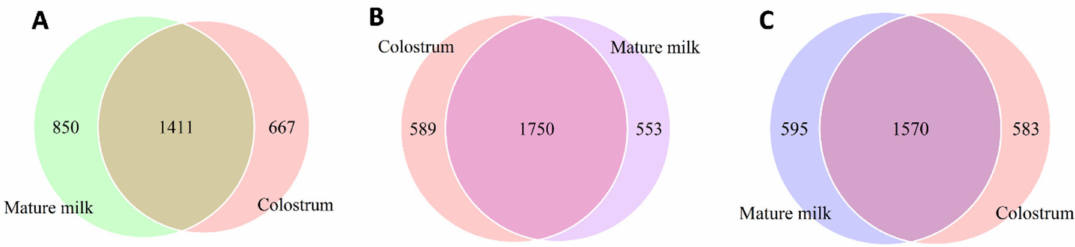
Figure 3. Venn diagram representing the number of bacterial operational taxonomic units (OTUs) in Saanen dairy goat colostrum and mature milk from three ( A – C )